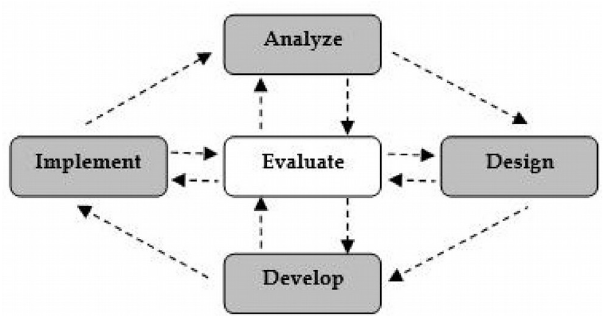
Figure 5. ADDIE development model scheme